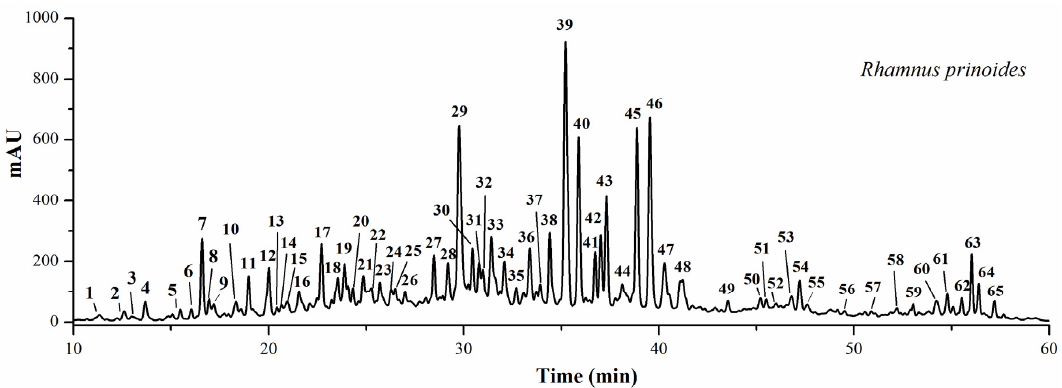
Figure 1. Anti-inflammatory activities of the semi-purified R. prinoides extracts (SPRE) of R. prinoides on NO production ( a ) and COX-2 inhibition ( b ). Results are expressed as the Mean ± SD (n = 3). Ctrl, normal control group; NC, negative group; ASP, aspirin; LPS, lipopolysaccharide; ** p < 0.01, compared with the NC group; ## p < 0.01, compared with the Ctrl group.